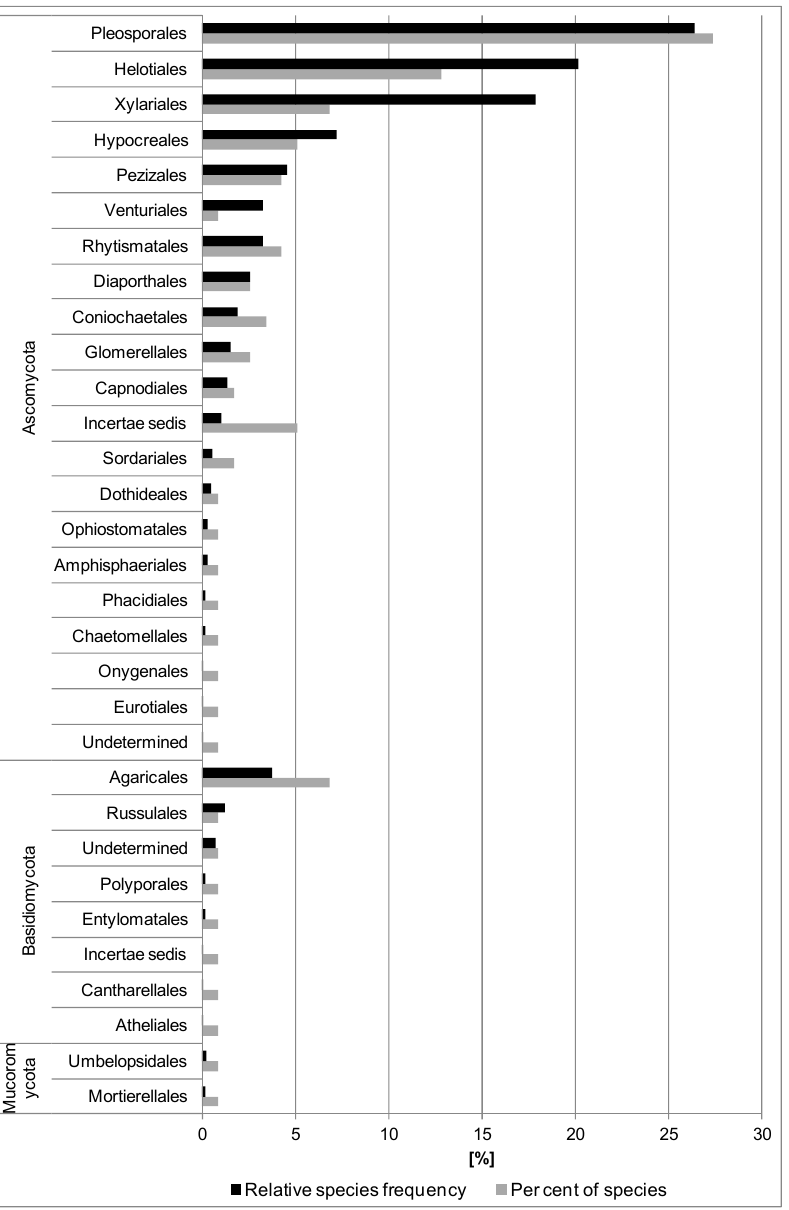
Figure 1. Frequency of fungi detected in situ on the previous year’s leaf petioles of F. excelsior . Relative species frequency calculated as the ratio of the number of specimens in the order to all specimens n = 1251. Percent of species calculated as the ratio of the number of species in the order to all species n = 117.